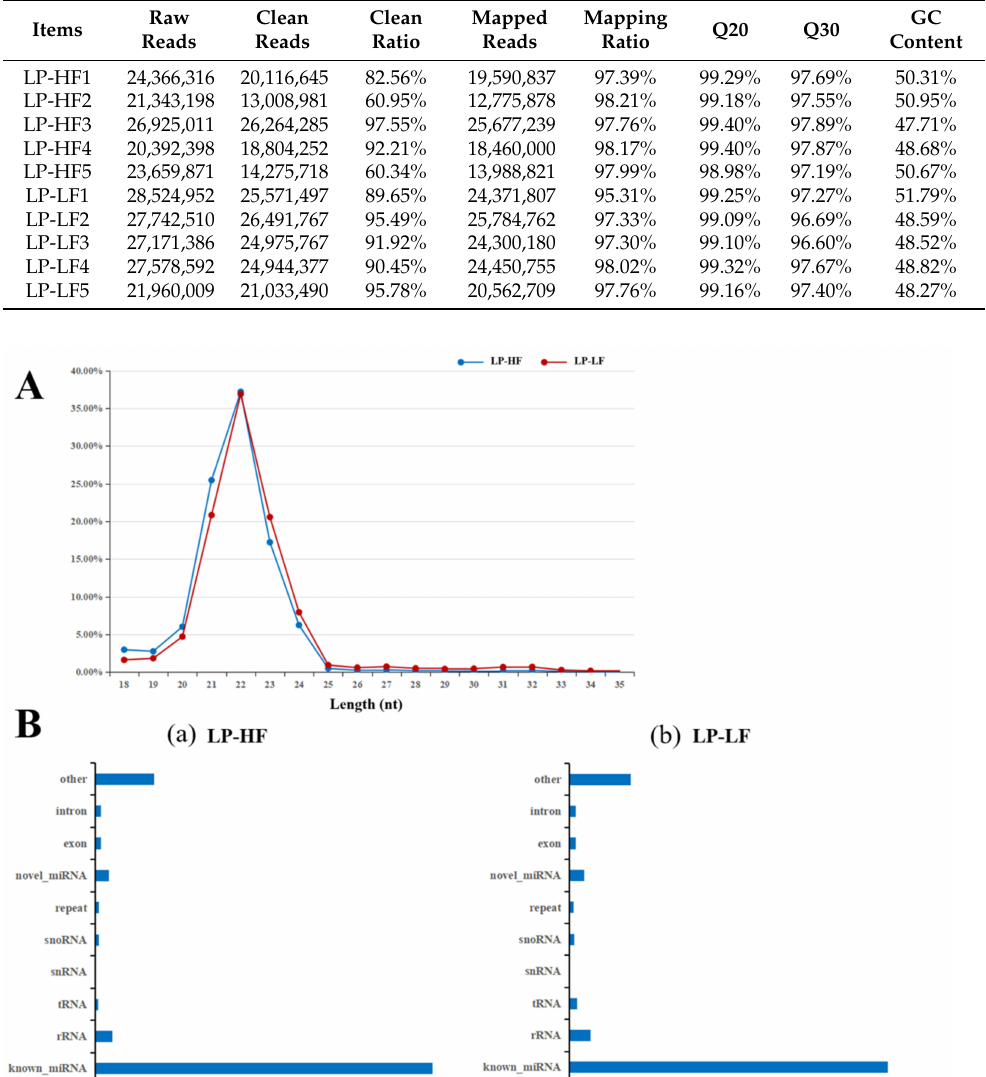
Table 3. Statistics for the small RNA library sequences of the hypothalamic tissue from the luteal phase.